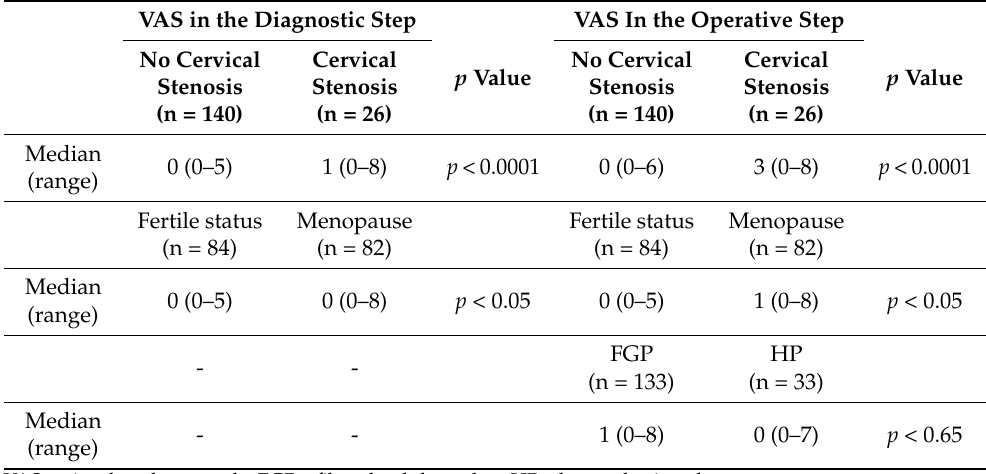
Table 2. Correlation of VAS score with patients’ clinical and intra-operative